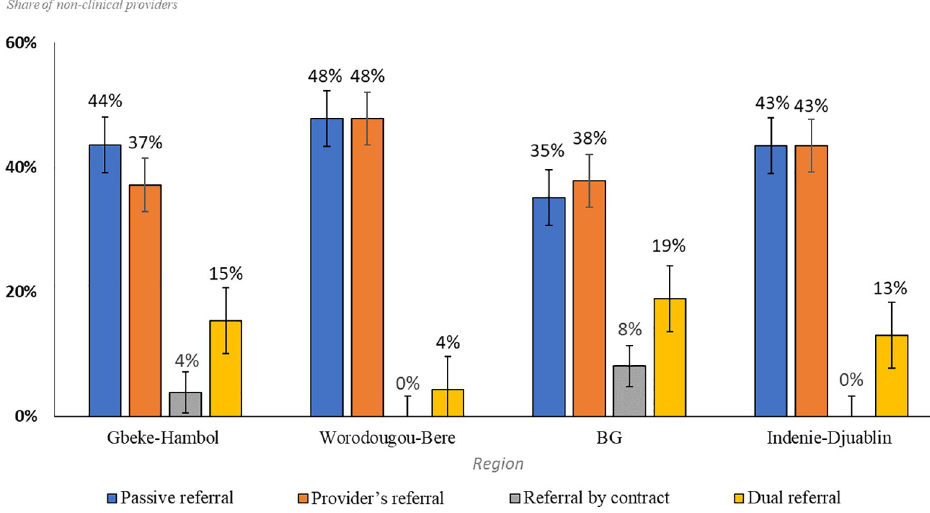
Fig 1. Which strategy do you most often use? Most utilized implementation strategy of contact tracing/testing strategies by